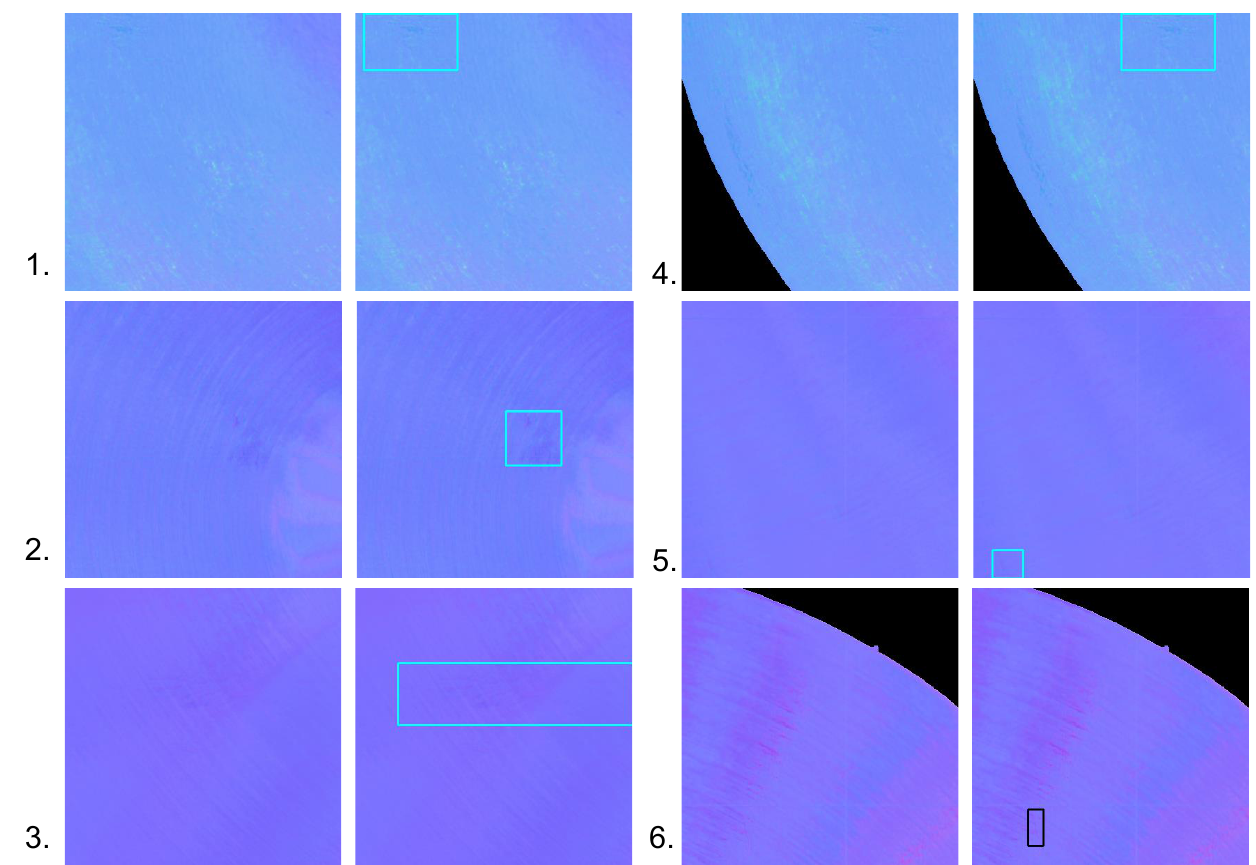
Figure 11. Detection failure cases. A total of 6 groups, of which groups 1–5 are abraded samples and group 6 is a scratch sample. The left image of each group is the estimated result and the right one is the ground truth. Boxes indicate the location of defects. For each group, the defect detection model did not identify the defect